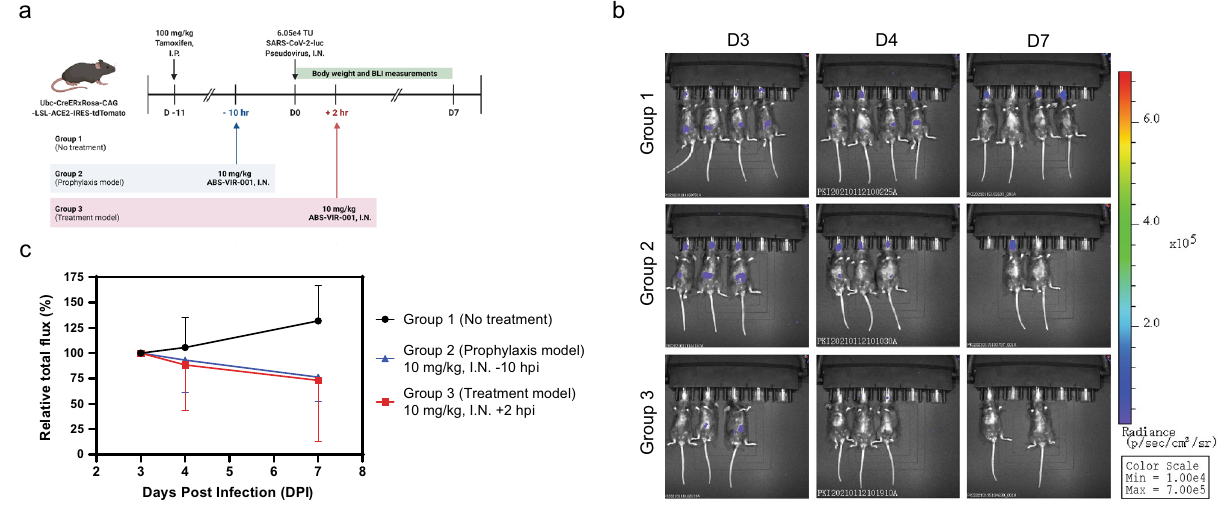
hpiGroup Group 3 (Treatment model) 10 mg/kg, I.N. +2 Figure 1. ABS-VIR-001 prevents SARS-CoV-2 pseudovirus infection in huACE-2 mice. Tamoxifen inducible ACE-2 mice were challenged with SARS-CoV-2-luc pseudovirus (intranasally, I.N.) and were randomly divided into 3 groups and treated as indicated and observed for body weight and bioluminescence (BLI). ( A ) Workflow of the pseudovirus animal study. ( B ) The bioluminescent imaging from D3, D4, and show drastic BLI reduction from D3 to D7 for Group 2 and Group 3, in contrast to the no treatment Group 1. (Error bars = SD) The graph was generated using the Prism (GraphPad) software v9.2.0 (https:// www. graph pad. com/). ( C ) The relative total flux percentage of the quantified BLI measurements show a decreasing trend for Group 2 and Group 3, in contrast to the negative control Group and monitored for body weight daily from D0 to D7 (Figure S1a) and BLI imaging and measurements from D3, D4, and D7 (Fig. 1b,c, respectively). The body weights of the antibody-treated animals were comparable to the no treatment control (Figure S1a), indicating that ABS-VIR-001 is well-tolerated. Importantly, the relative total flux percentage from the BLI imaging and measurements clearly decreased in trend for both the prophylaxis model and treatment model in contrast to the no treatment group (Fig. 1b,c), which was initially more dramatic for the prophylaxis group (Figure S1b). Overall, this data suggests that ABS-VIR-001 is highly efficacious as a prophylaxis and as a post-exposure treatment against the SARS-CoV-2-luc pseudovirus via the intranasal route. ABS‑VIR‑001 prevents SARS‑CoV‑2 infection and decreases viral burden after infection in huACE‑2 mice. Based on the success of the pseudovirus study, we next assessed the efficacy of ABS-VIR-001 on an authentic SARS-CoV-2 challenge model using mice constitutively expressing huACE-2 (Fig. 2a). First, the appropriate virus inoculation dose was assessed in this mouse model (Table S1). In this initial analysis, it was determined that 1000 PFU established the most consistent and high titers within the group in comparison to the other inoculation groups by D3 (Table S2). Furthermore, mice inoculated at the lower doses already displayed an increase in pathological changes from 10 to 100 PFU in the mouse lung tissue (Figure S2a and Table S3). Taken together, a new set of mice were divided into four groups (Fig. 2a); a no treatment group (Group 1), an I.N. prophylaxis group (Group 2, at 25 mg/kg ABS-VIR-001 10 h prior to virus challenge), an I.N. treatment group (Group 3, at 25 mg/kg ABS-VIR-001 2 h post virus challenge) and an I.P. treatment group (Group 4, at 10 mg/kg ABS-VIR-001 2 h post virus challenge). At day 0 (D0), the mice were challenged with 1000 PFU of SARS-CoV-2 virus and monitored for body weight daily from D0 to D3 (Figure S3a) and lungs were harvested for viral titer measurements on D3 (Fig. 2b). No weight loss was observed in the I.N. prophylaxis group in all the animals within the group, and the body weights of the other groups were comparable to the no treatment control group (Figure S3a and Table S1), indicating the safety of ABS-VIR-001 for both the I.N. and I.P. route. Importantly, the lung viral titer measurements decreased for both the prophylaxis model and treatment models in contrast to the no treatment group (Fig. 2b), which was most significant for the I.N. for the prophylaxis group with 3 out of the 4 animals showing undetectable levels of virus and the treatment models with about 11- or 50- fold reduction in virus in comparison to the no treatment group. After D3, all mice within the I.P. Treatment group survived (Group 4) or showed similar survival (Groups 2 and 3) as the no treatment group (Group 1), indicating that ABS-VIR-001 is well-tolerated and more importantly, ABS-VIR-001 prevented death (Fig. 2c). This data sug- gests that ABS-VIR-001 is highly efficacious as a prophylaxis treatment and as a treatment for SARS-CoV-2 via the I.N. and I.P. (surrogate for the I.V.) route. We previously observed that a mouse from Group 2 and a mouse from Group 3 were found dead on D7 in the initial SARS-CoV-2-luc pseudovirus infection study. In this regard, we carried out an in vivo safety study of ABS-VIR-001 on immunodeficient mice to rule out any safety concerns associated with ABS-VIR-001. Mice were divided into four groups and at D0, each mouse was treated in the following manner: a PBS group